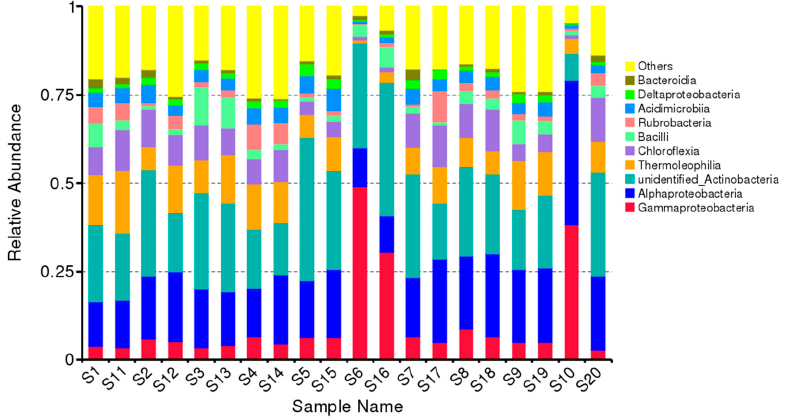
Figure 3. Total relative abundance of the top ten classes of bacteria. S represents the sample. Numbers from 1–10 represent different species of desert plants from which the samples were collected in monsoon season (August). Whereas the numbers S11-S20 represent the same species of desert plants from where samples were collected in dry season (March). Monsoon vs. dry season: (S1 vs. S11) Cleome pallida Kotschy, ( S2 vs. S12) Tamarix aphylla. , (S3 vs. S13) Capparis decidua (Forssk.) Edgew , (S4 vs. S14) Calligonum polygonoides , (S5 vs. S15) Calotropis procera (Ait.) Ait. , (S6 vs. S16) Leptadenia pyrotechnica , (S7 vs. S17); Cymbopogon jwarancusa, ( S8 vs. S18) Haloxylon salicornicum , (S9 vs. S19) Aerva javanica (Burm. f.) Juss. ex Schult. and (S10 vs. S20) Vachellia jacquemontii (Benth.) .